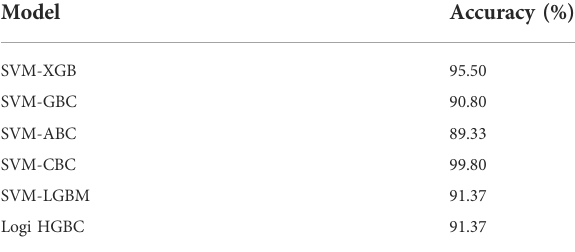
TABLE 4 Comparative Analysis for the detection of FDI.